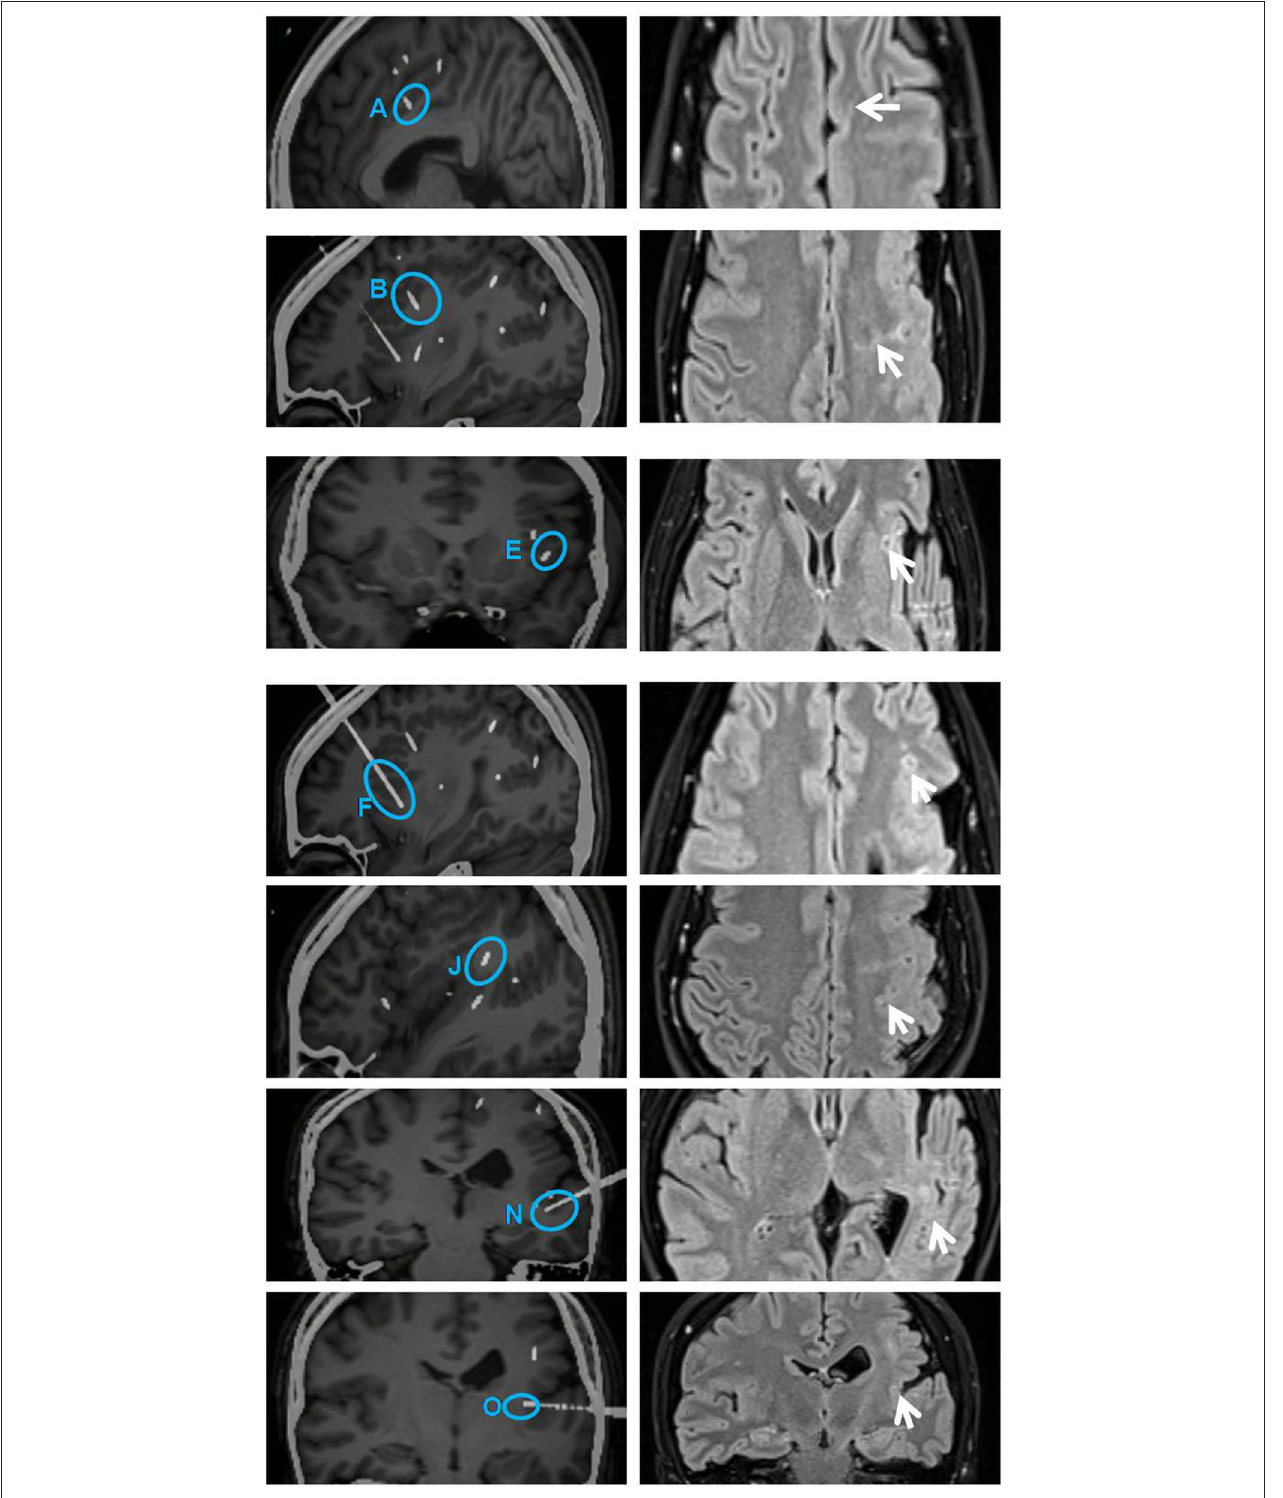
FIGURE 4 | Illustration on the left shows secondarily involved electrodes A (contacts 1 and 2), B (contacts 1–10), E (contacts 1–4), F (contacts 1–9), J (contacts 3–10), N (contacts 1–5), and O (contacts 1 and 2) (highlighted with blue circles). All these contacts were subjected to RF-TC 2 weeks after the first thermocoagulation. Illustration on the right shows sites of coagulation in the same region on an MRI image acquired 6 months later (arrows on the right). The diameter of lesions ranged from 4 to 5mm. RF-TC, radiofrequency thermocoagulation.